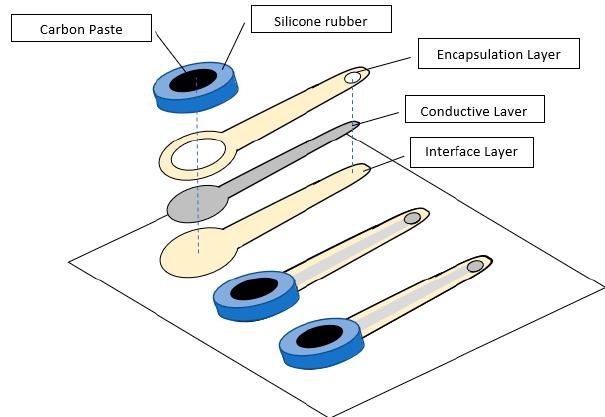
Figure 2. Exploded view of printed